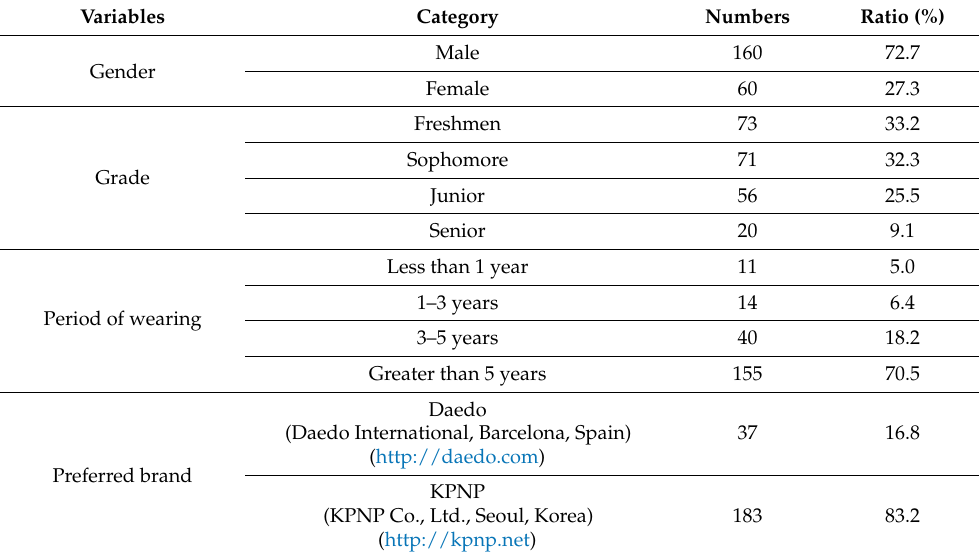
Table 1. Demographics of the participants (N = 220).